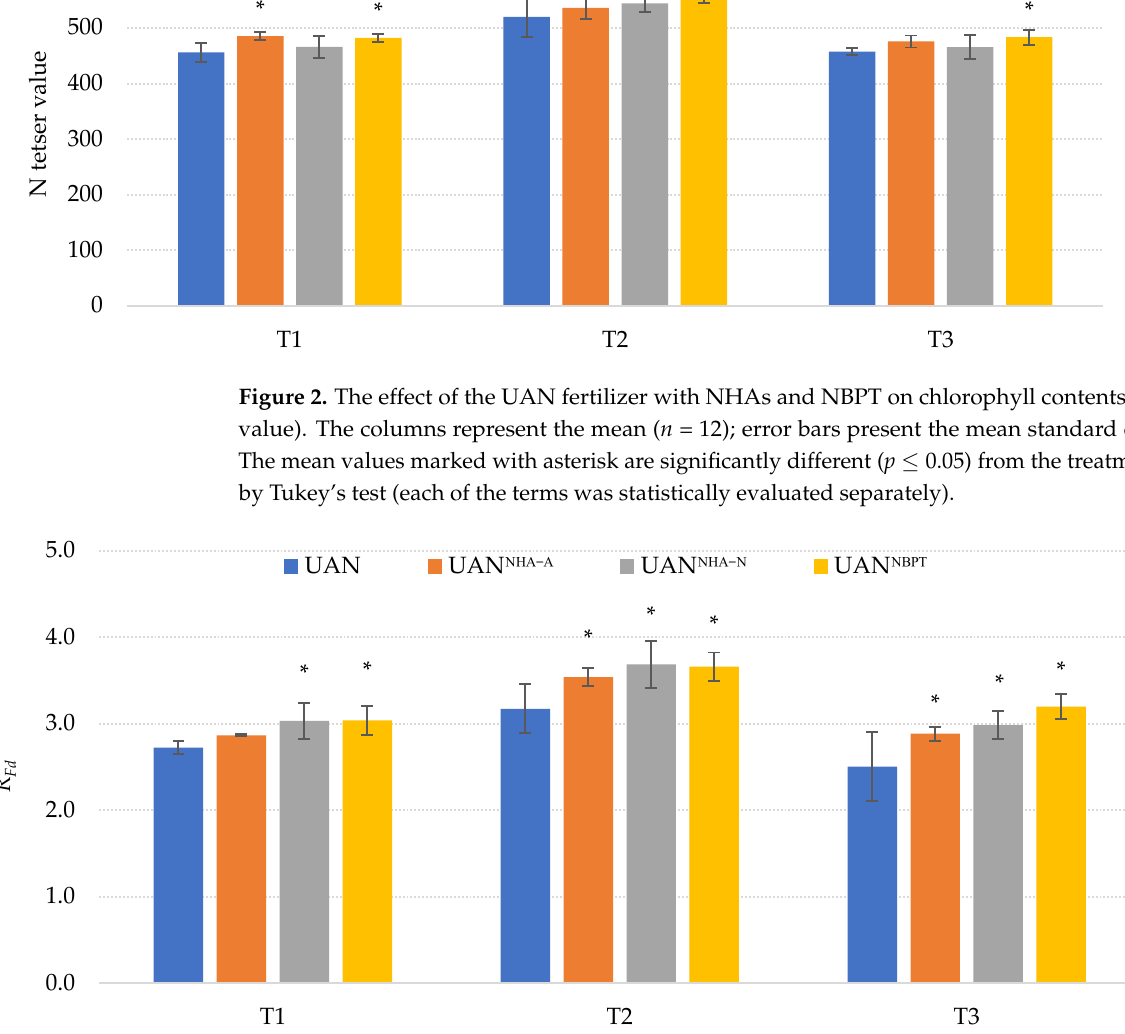
Figure 2. The effect of the UAN fertilizer with NHAs and NBPT on chlorophyll contents (N-tester value). The columns represent the mean ( n = 12); error bars present the mean standard deviation. The mean values marked with asterisk are significantly different ( p ≤ 0.05) from the treatment UAN by Tukey’s test (each of the terms was statistically evaluated separately).